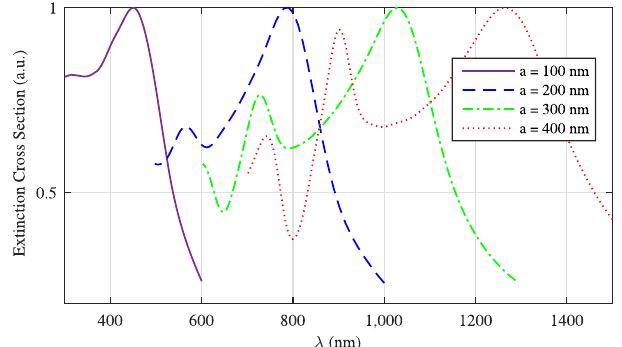
Figure 9. Simulated SPR of copper oxide nanocubes of different size; increasing the nanocubes size leads to red shift in SPR wavelength and also excitation of the higher order resonance